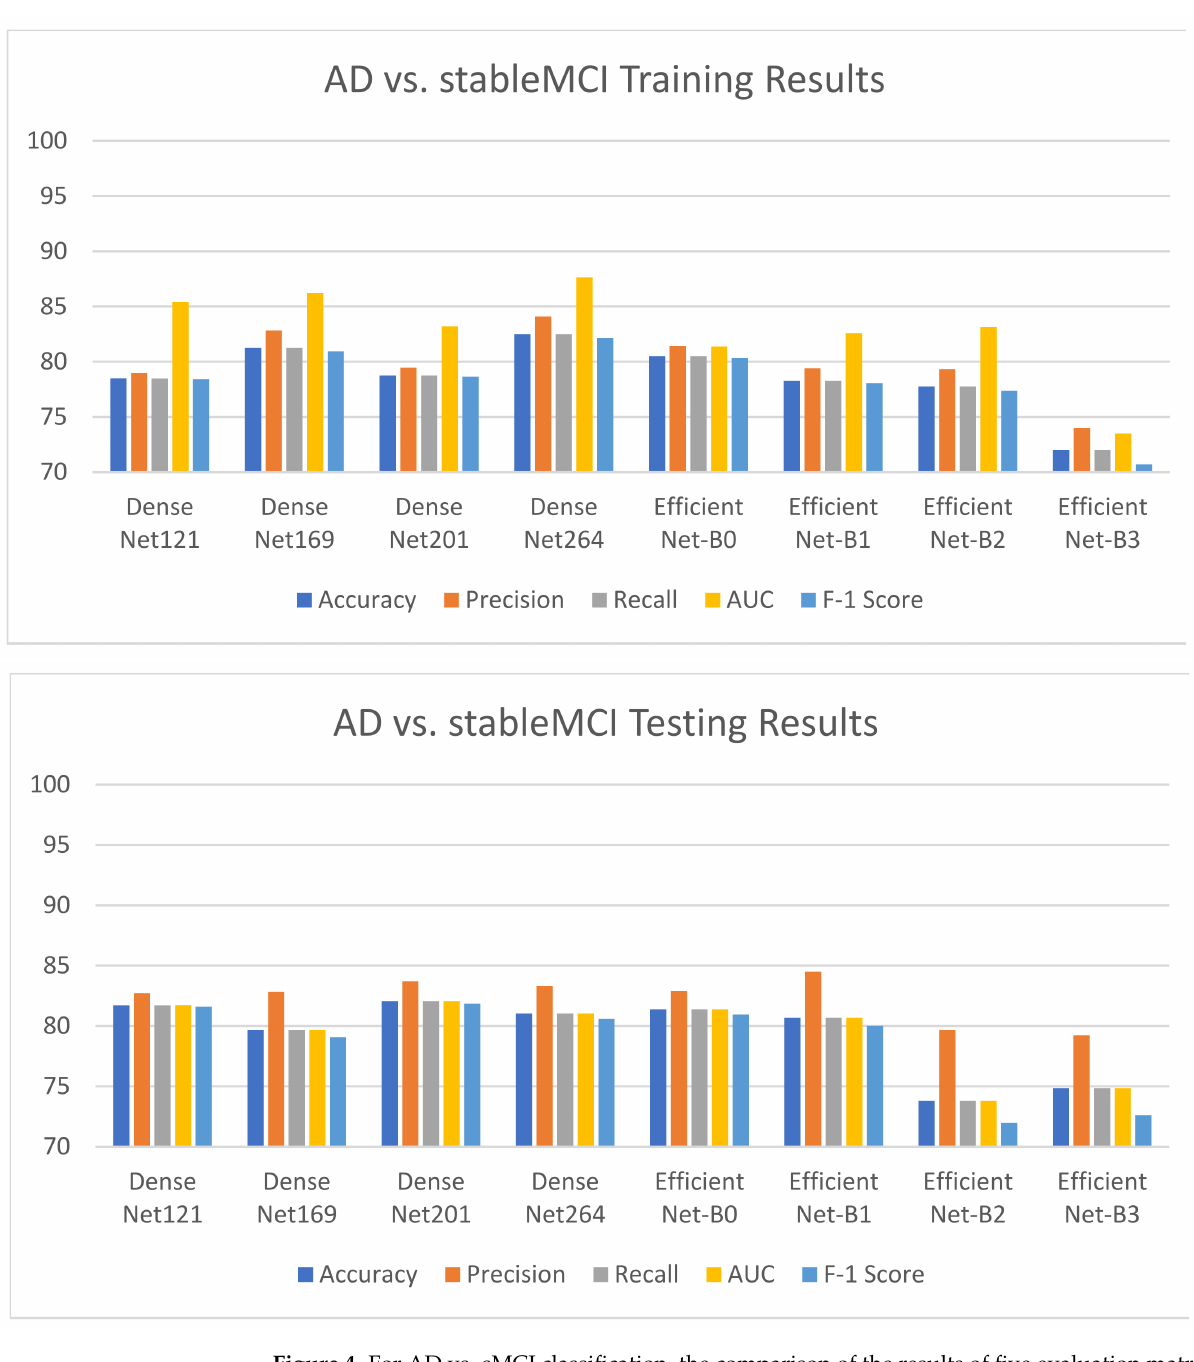
Figure 4. For AD vs. sMCI classification, the comparison of the results of five evaluation matrices of eight DL models with epoch = 50 and batch size =